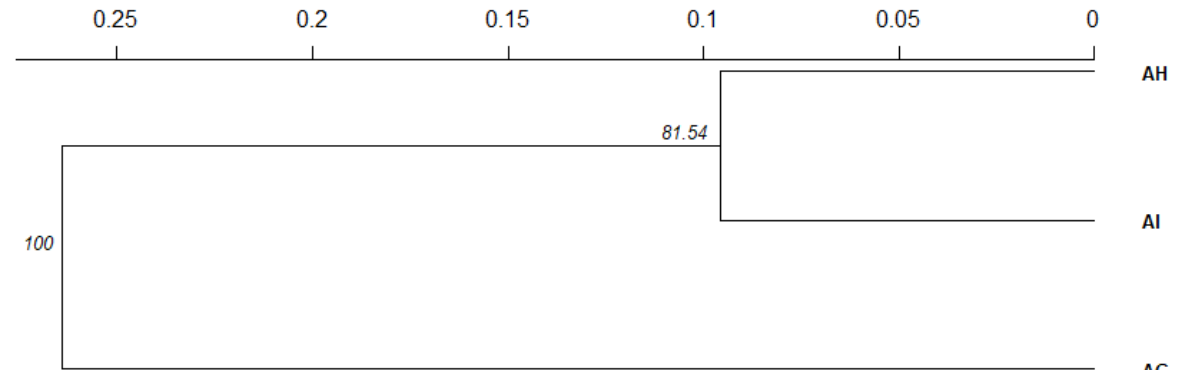
lite markers. The graph shows the individuals as dots and the groups as inertia ellipses. Eigenvalues of the PCs are displayed